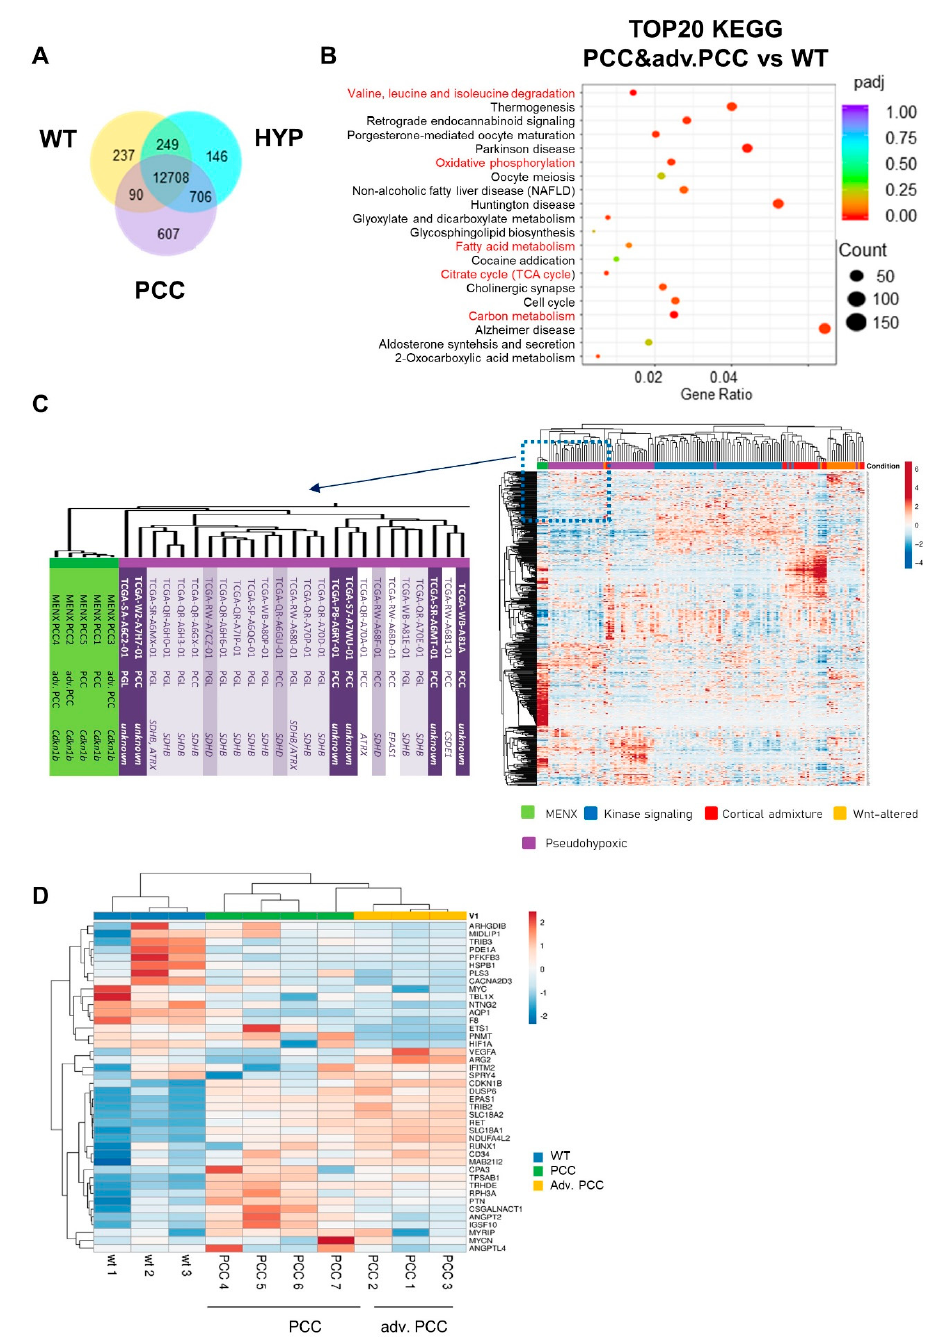
Figure 2. Analysis of rat transcriptome and the comparison to the human The Cancer Genome Atlas’ (TCGA) pheochromocytoma and paraganglioma (PPGL) dataset. ( A ) Venn Diagram depicting the unique and differentially expressed genes among wildtype (WT; n = 5), hyperplasia (HYP, n = 5) and pheochromocytoma (PCC + adv. PCC, n = 5) samples found by RNA-seq analysis. ( B ) Top 20 most significantly enriched KEGG pathways based on the differentially expressed genes between rat datasets (WT and PCC) are depicted in the dot graph. ( C ) Comparison of the MENX PCC transcriptome to the human TCGA PPGL dataset by the consensus clustering of the 500 most differentially expressed homologous genes between rat PCC and human PPGL. Both rows and columns are clustered using correlation distance and average linkage. The 25 patient samples closest to the rat PCCs are enlarged and their driver mutations are reported. ( D ) RT-PCR-based array analysis of selected relevant classifier genes. Shown is the consensus clustering and the heatmap of WT normal adrenal (n = 3), MENX PCC (n = 4) and advanced PCC (n = 3) of 7.5–9-month-old